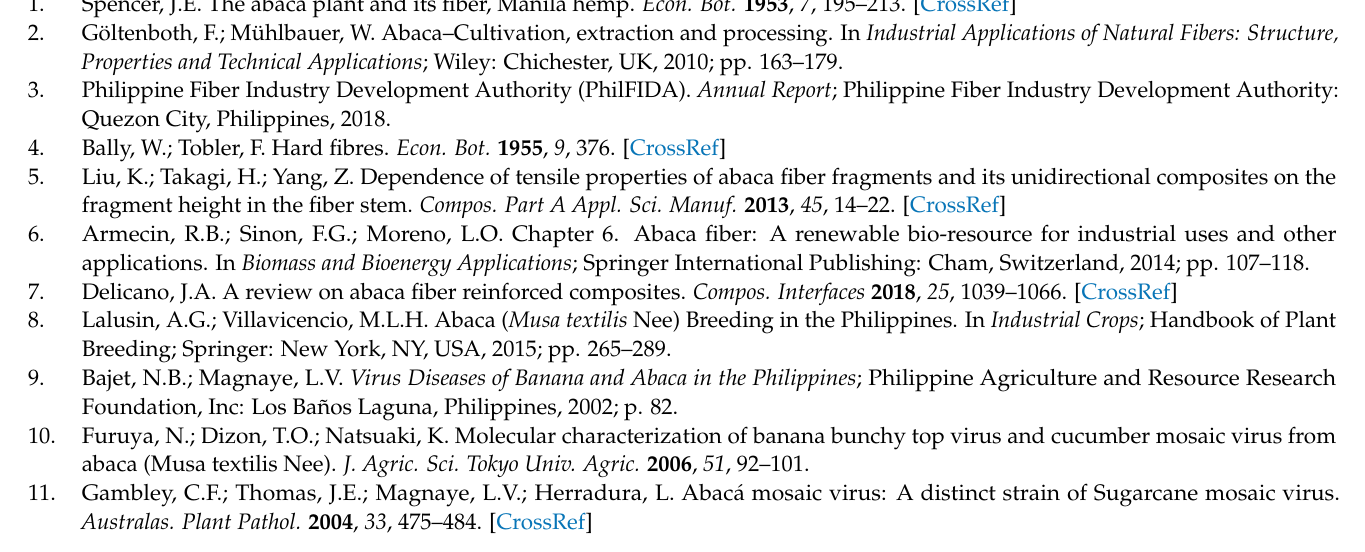
Table S2. The total Orthogroups from eight plant species. Table S3. Summary of gene family clustering. Table S4. Overlapping orthologous groups among the eight